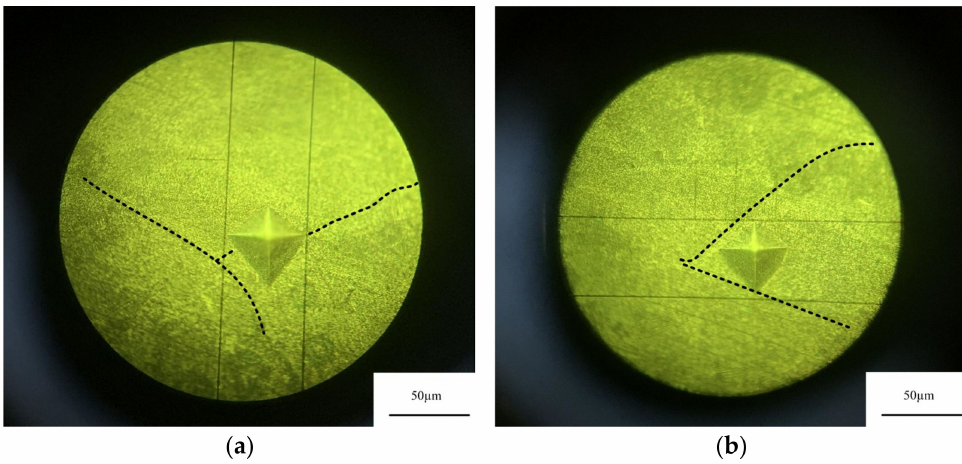
Figure 14. Microstructure of annealed state hardness test. ( a ) melt pool boundary, ( b ) melt